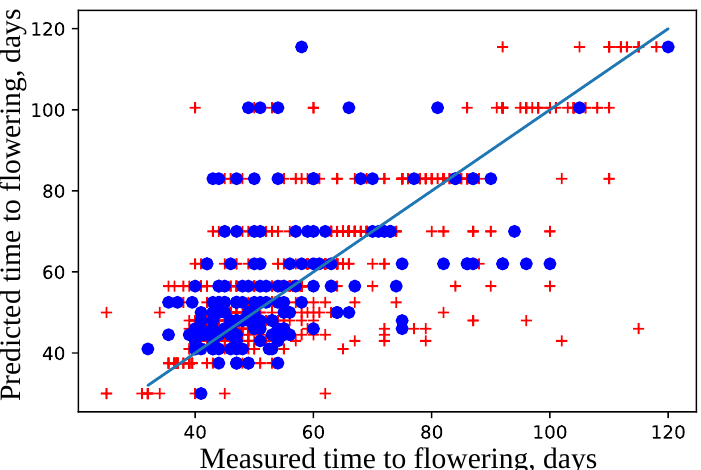
Figure 9. Comparison of measured and predicted flowering time. The data points used for training are marked with red crosses, and those from the test set are drawn as blue dots. The straight line represents the exact correspondence. The model accuracy is a =